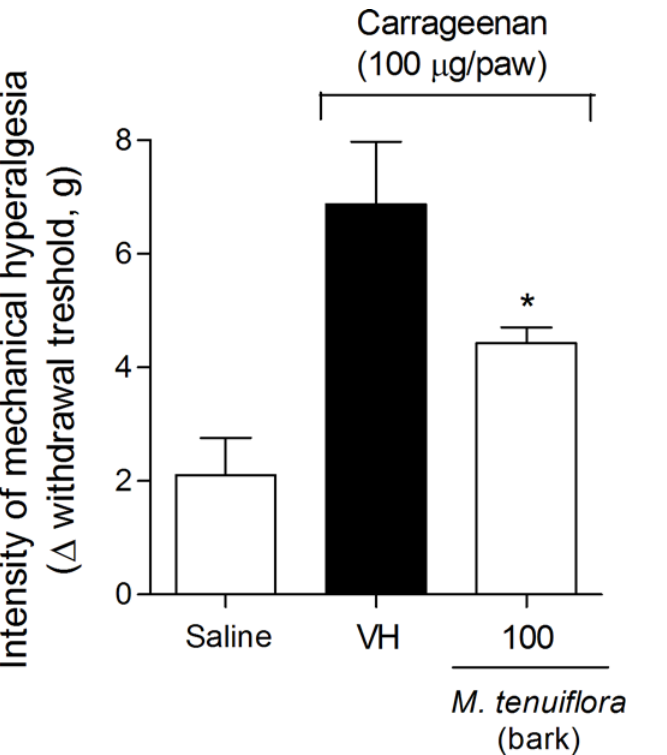
Fig 7. Effect of ethanolic extract of M . tenuiflora bark on the inhibition of Cg-induced hyperalgesia. VH is the vehicle group (negative control). The ethanol extract of M . tenuiflora bark was tested at a dose of 100 mg/kg (s.c.). The results are presented as the mean ± S.D. (n = 8). Statistical significance was calculated by ANOVA followed by Bonferroni's test. * P < 0.05 compared to the vehicle-negative control treated